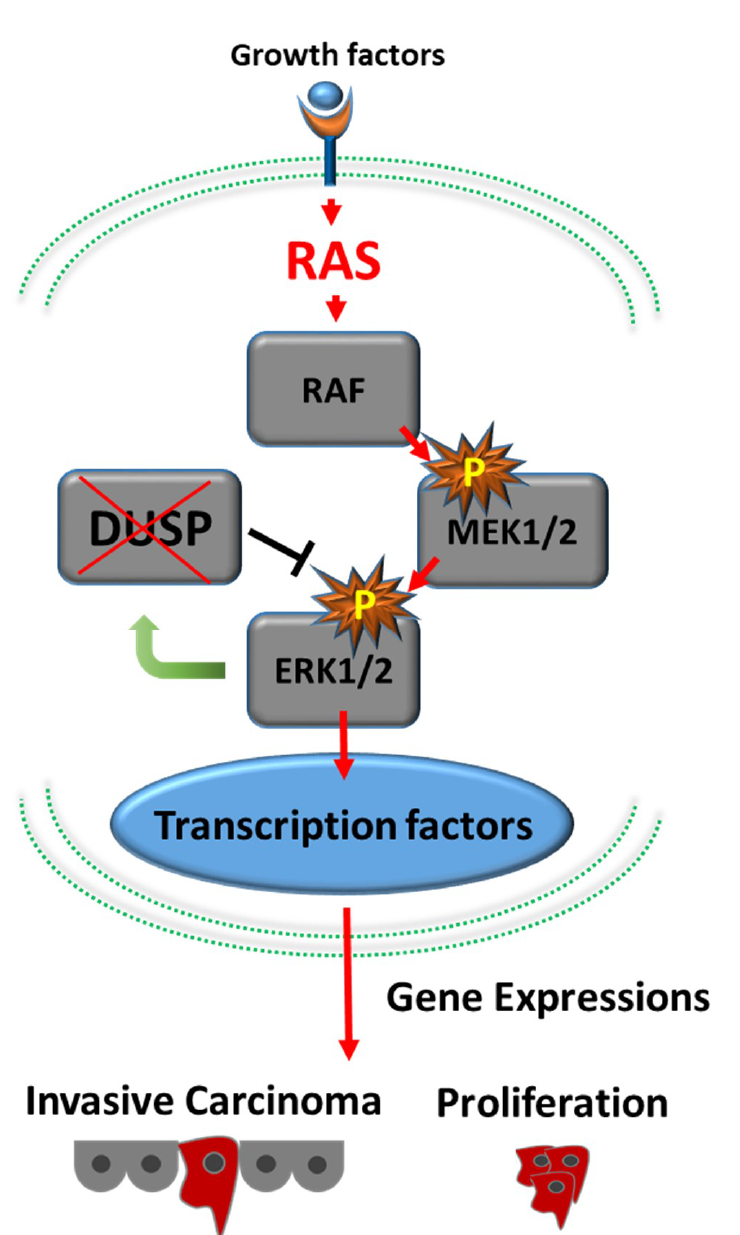
Figure 1. Development of pancreatic adenocarcinoma via the RAS–MAPK signaling cascade. Active RAS generated by mutated Kras activates downstream cascades, including RAF1–MAP2K1–MAPK1. Loss of expression of DUSP6 results in abrogation of the feedback loop between MAPK1 and DUSP6 and leads to constitutive activation of MAPK1, which eventually results in invasive phenotypes. Activation of Kras and inactivation of p16 Ink4a (CDKN2A) lead to the formation of low-grade PanIN-2 lesions [18]. Moreover, cell proliferation increases after Kras oncogene activation. To maintain the balance between cell division and apoptosis, TSGs are turned on and cell-cycle arrest is triggered. However, if TSGs are inactivated because of deletion or mutation, the increased cell cycles are no longer inhibited. Cell proliferation increases when the Kras oncogene is